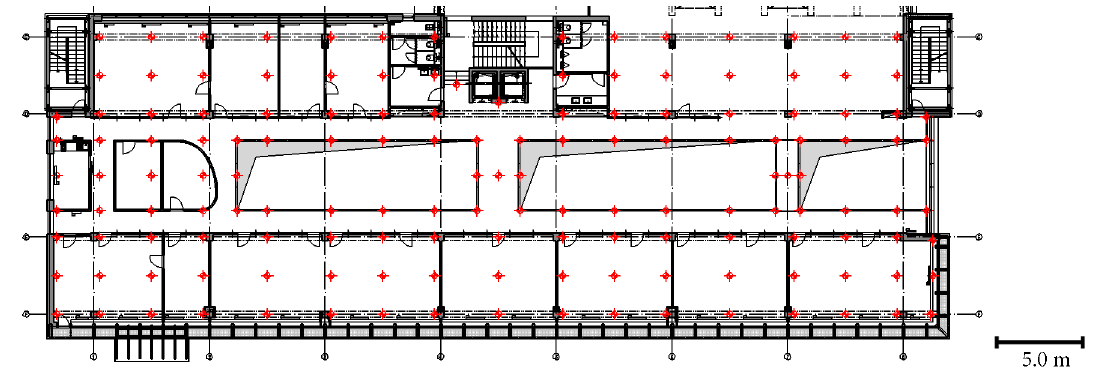
Figure 7. The layout of measured detailed survey points on the 2 nd AGL floor